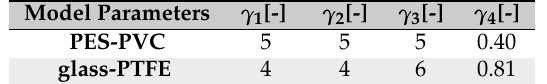
Table 3. The previously identified model parameters for glass-PTFE and PES-PVC fabrics. Model